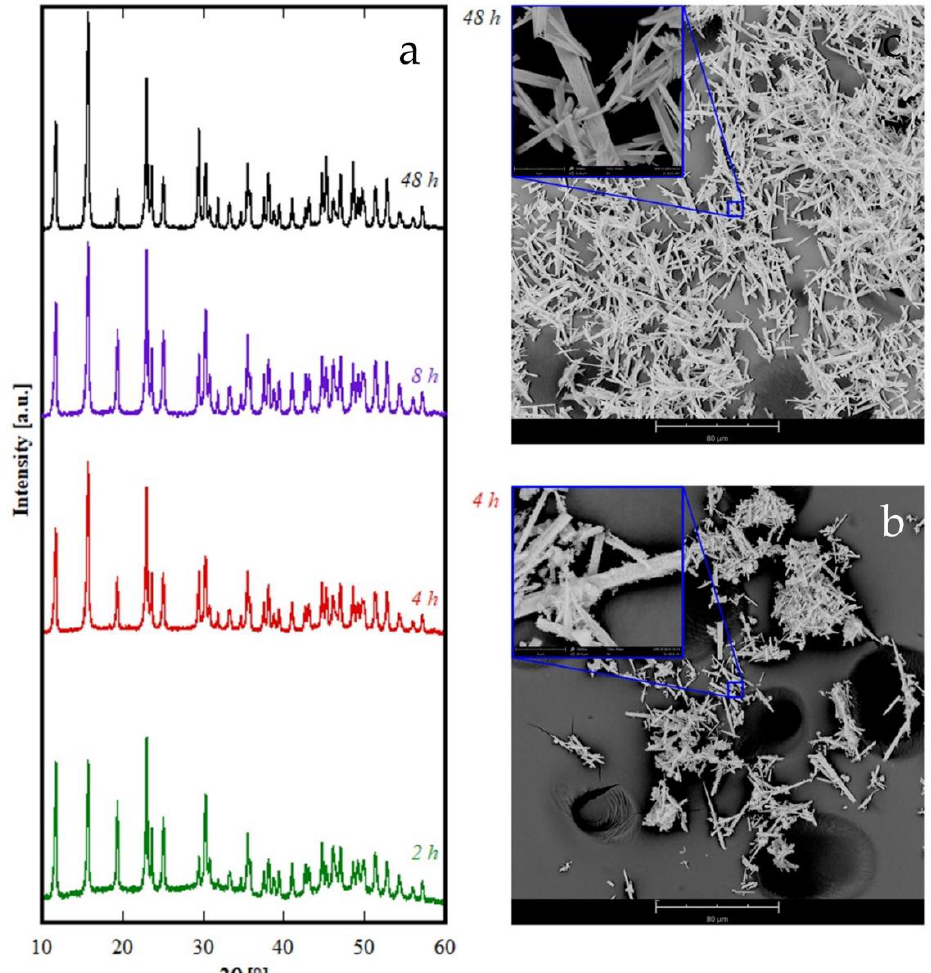
Figure 6. Diffraction patterns ( a ) and SEM micrographs of samples containing Er synthesized at 4 h ( b ) and 48 h ( c ).